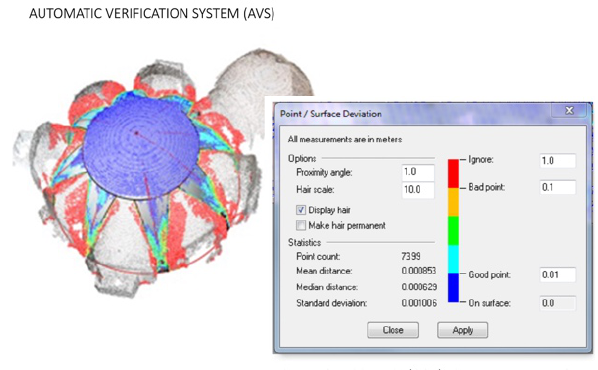
Figure 6. NURBs model with a GoA of 1 mm